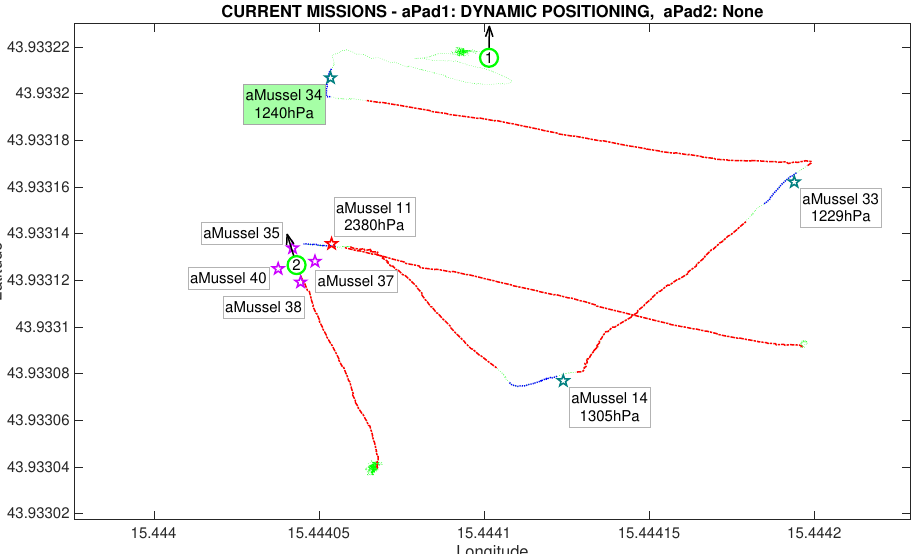
Figure 15. Second deployment started in the Anoxia scenario experiment results from the deployment phase, reconstructed and replayed from recorded vehicle data—Biograd na Moru testbed.